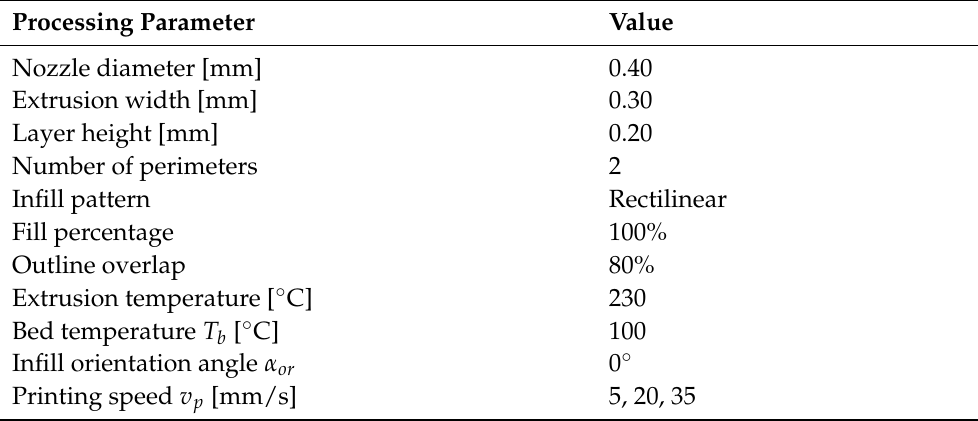
Table 1. Processing parameters used to manufacture ME-AM tensile